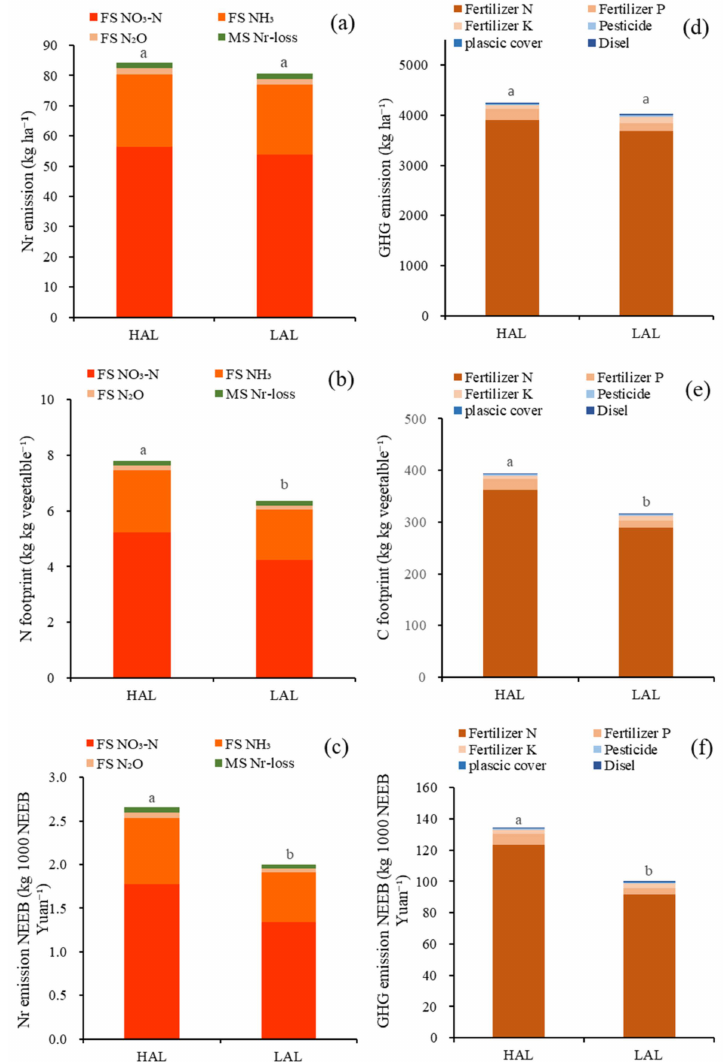
Figure 1. Reactive N loss ( a – c ) and greenhouse gas emission ( d – f ) on per ha, tonne of vegetable and 1000 NEEB Yuan basic of pepper production in HAL and LAL. HAL represents the high-altitude level (500–800 m), LAL represents the low-altitude level (900–1200 m). The lowercase letters represent significant differences according to least significant test ( p <